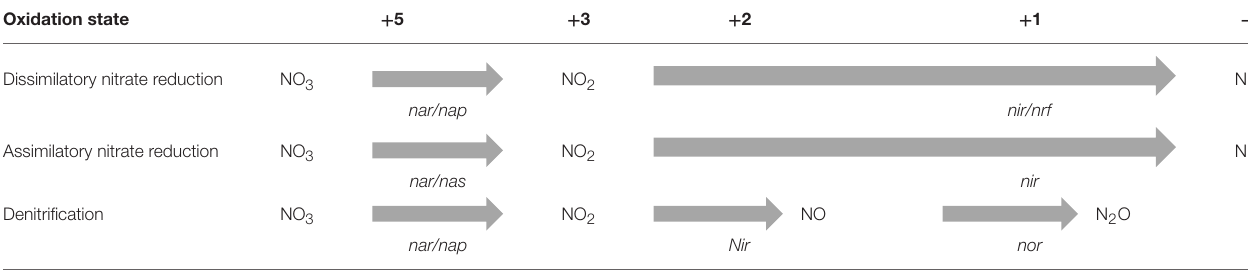
TABLE 2 | Microbial nitrogen metabolism in the rumen a . Oxidation state + 5 + 3 + 2 + 1 − 3 Dissimilatory nitrate reduction NO 3 NO 2 NH 4 nar/nap Assimilatory nitrate